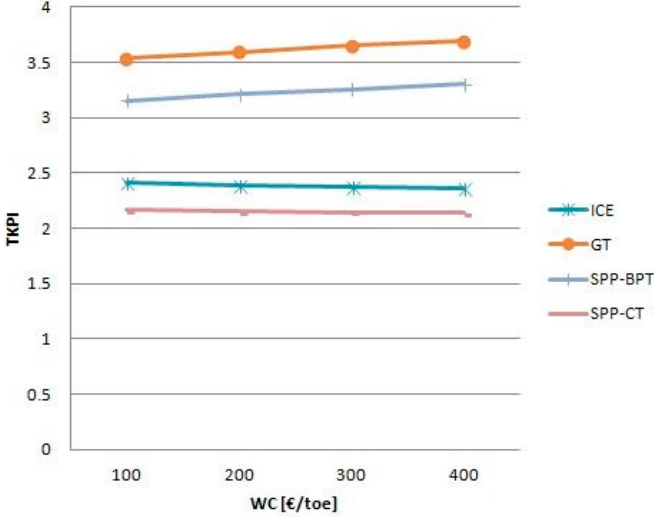
Figure 13. TKPI sensitivity analysis for varying incentive values (optimal design).